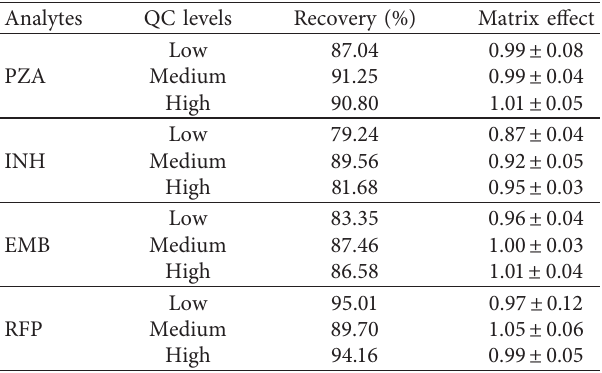
Table 4: Recovery and matrix effect of four analytes in QC sample at three levels ( n �